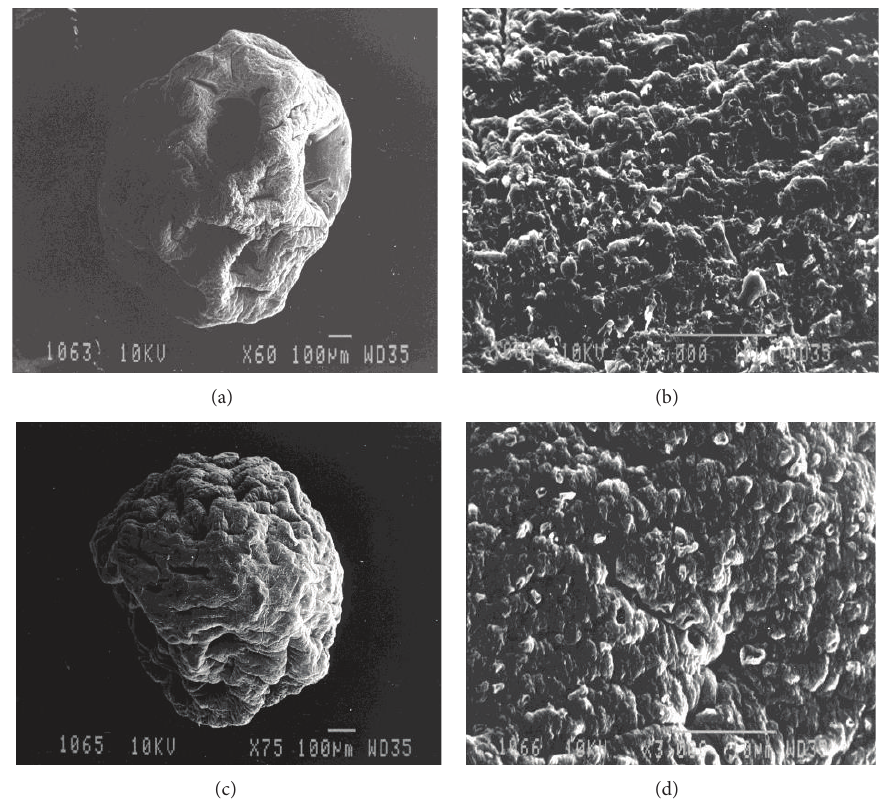
Figure 1: Scanning electron micrographs of (a) alginate beads containing probiotic (60x), (b) alginate beads containing probiotic (300x), (c) AL-CA beads containing probiotic (60x), and (d) AL-CA beads containing probiotic (3000x).